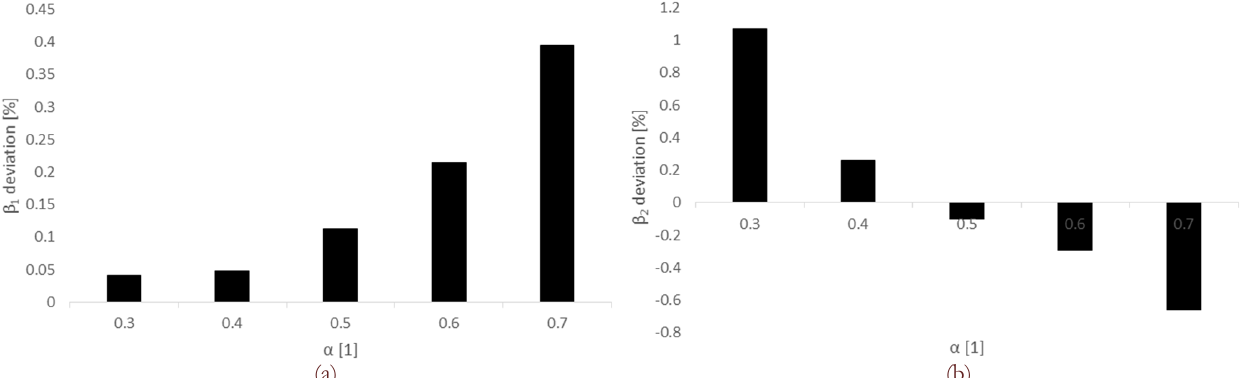
Figure 6: The maximal percentual difference for various WST specimen compositions: a) for biaxial parameter B 1 and b) for biaxial parameter B 2